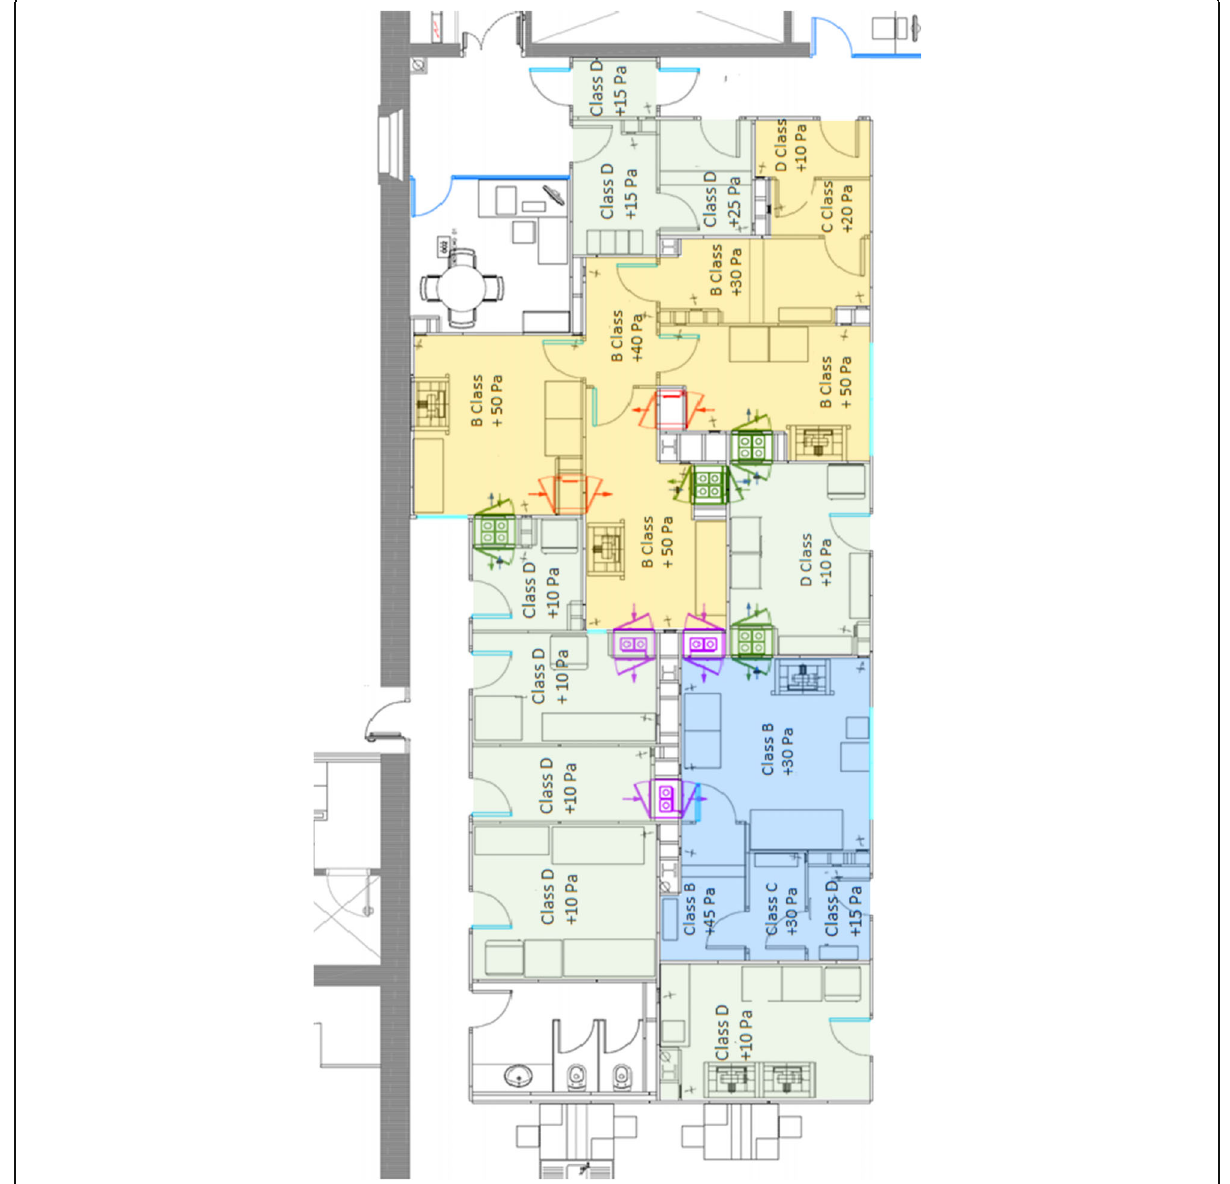
Fig. 1 Layout of Creatio GMP facility. The facility is controlled by three independent Heating Ventilation and Air Conditioning (HVAC) systems (orange, blue and green). In white, non-classified areas. In orange, HVAC-1. In blue, HVAC-2. In green, HVAC-3. Rooms belonging to HVAC-3 have a pressure of 10 Pa and are dedicated to storage and product conditioning. Cell therapy products are manufactured in HVAC-1. Cleanrooms (Grade B) belonging to HVAC-1 have a pressure of 50 Pa, adjacent rooms have a differential pressure of 10 – 15 Pa. HVAC-2 is dedicated to gene therapy products. Access to gene therapy cleanrooms (Grade B) is granted through dressing rooms which have a differential pressure of 10 – 15 Pa. In this case, Grade B cleanroom is under pressured (30 Pa) compared to the adjacent dressing room (40 Pa) as a physical containment barrier to avoid viral